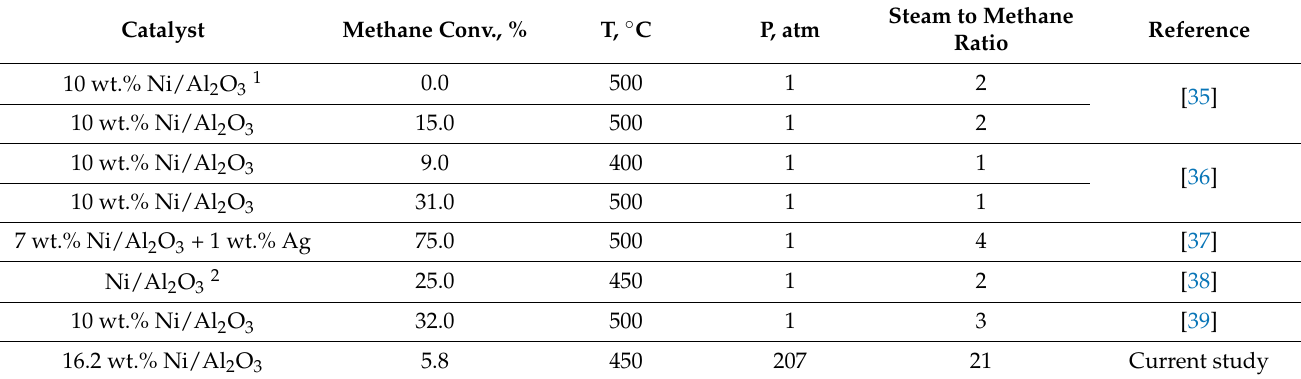
Steam to Methane Ratio